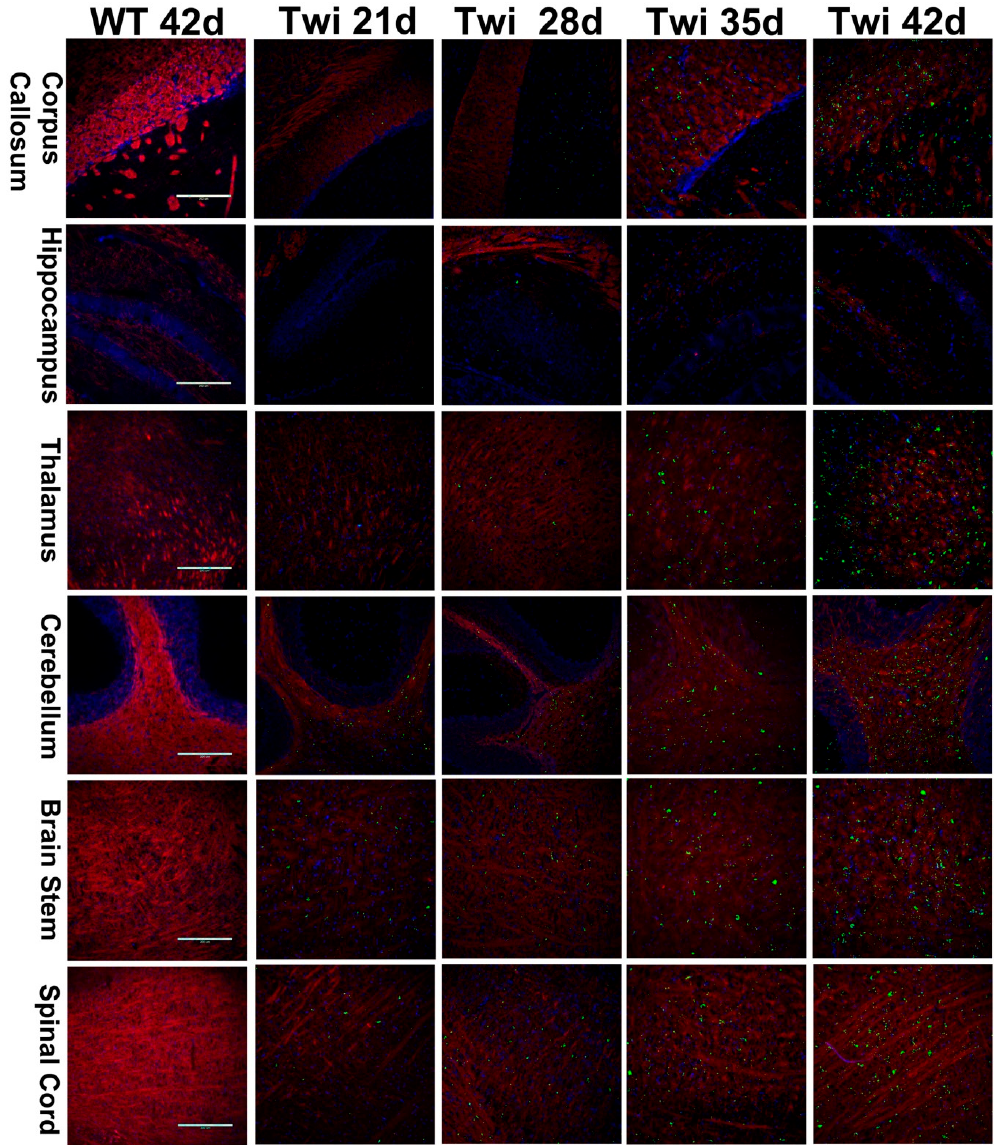
Figure 1. Spatial and temporal distribution of ubiquitin aggregates in the brain of twitcher mice. Distribution of ubiquitin aggregates in different regions of the twitcher (Twi) brain at ages 21 to 42 days. The twitcher brain and wild-type (WT) brain were immuno-stained with anti-ubiquitin (in green) and anti-PLP (in red), respectively, and nuclei were counterstained with DAPI (in blue). Scale bars: 200 μ m.